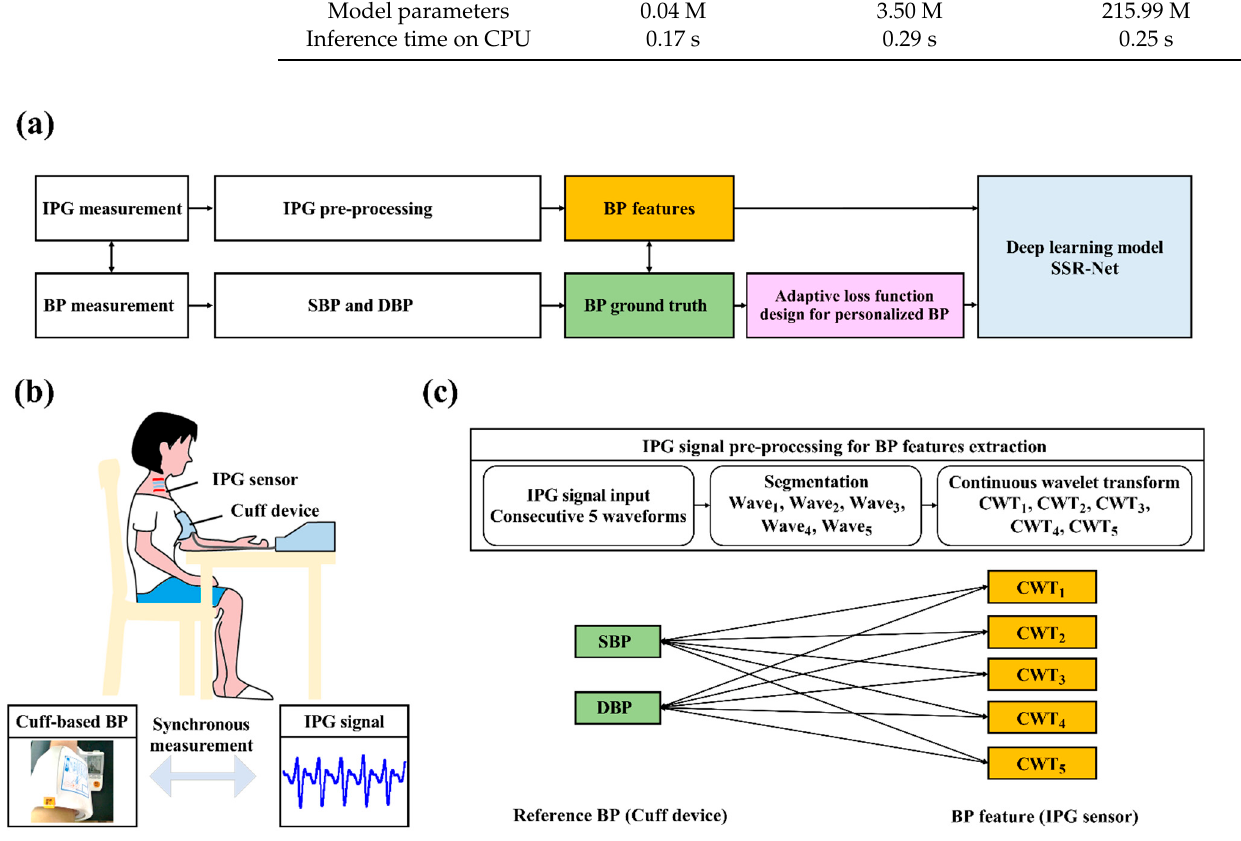
Figure 3. ( a ) Experiment flow chart for physiological acquisition, data pre ‐ processing, and BP estimation. ( b ) Synchronous measurement between the proposed sensor and cuff ‐ based device. ( c ) IPG signals were pre ‐ processed for further BP feature extraction, including signal segmentation and continuous wavelet transform.